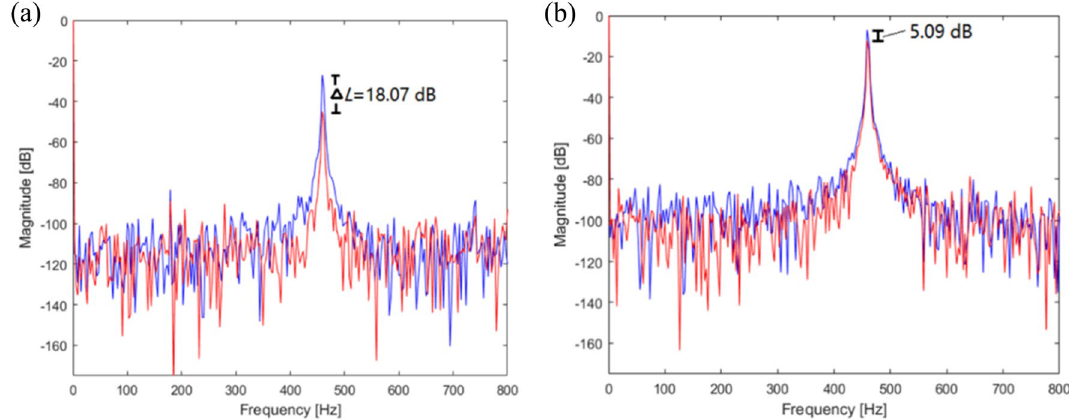
Figure 22. Comparison of measured accelerometer spectra for amplitude sinusoid signals: ( a ) actuator 1; ( b ) actuator 2. Key: blue line uncontrolled; red line controlled.